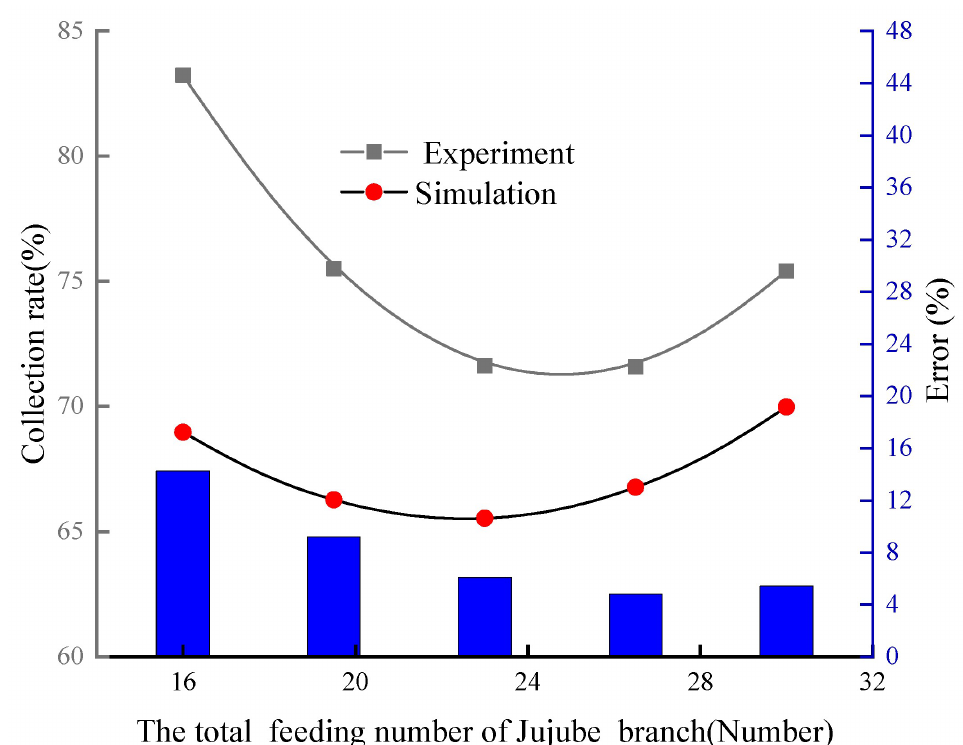
Figure 9. Relationship between the total number of jujube branches and the picking